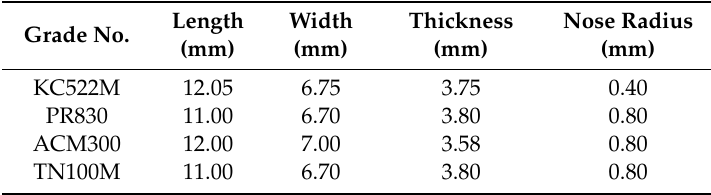
Table 1. The geometries of coating tools.